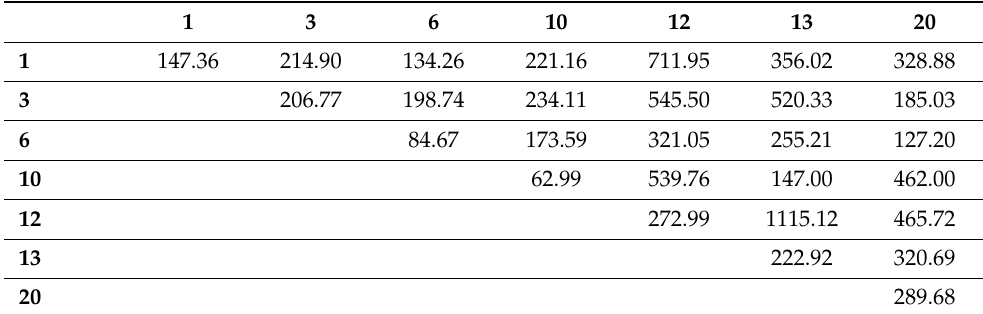
Table 5. Market yield (g/plot) of parents (on diagonal) and experimental hybrids (above diagonal) for Set 2. See Table 1 for parental codes. Least square differences between means = 209.4, p < 0.05.